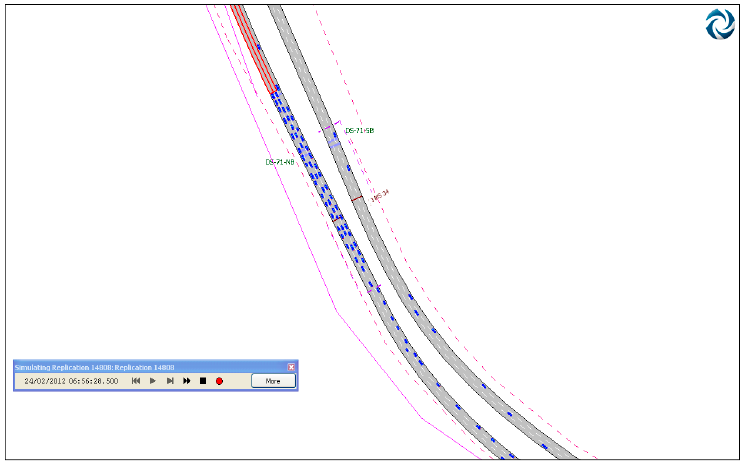
Figure 10. The Aimsun network while running the simulation showing the virtual crash scenario. Two scenarios were simulated for both the Gipps and SBM, both with and without VSL systems for the queue protection (QP) algorithm. Figure 11a shows that the Gipps model is not sensitive to the application of the VSL, and as a result cannot be used for evaluating intelligent transportation systems such as VSL. The mean TTC values for both scenarios are almost the same. The short headway frequencies have only decreased by 15% after the application of VSL.